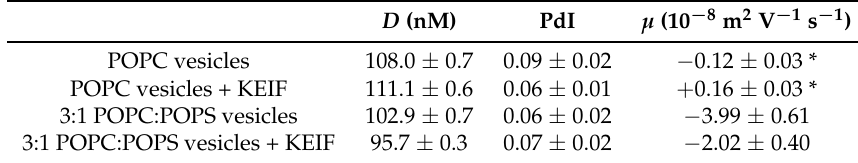
Table 6. Z-average diameter, polydispersity index, and electrophoretic mobility of POPC and 3:1 POPC:POPS vesicles in absence and presence of KEIF, at 10mM NaF in TRIS buffer. Lipid:KEIF molar ratio was